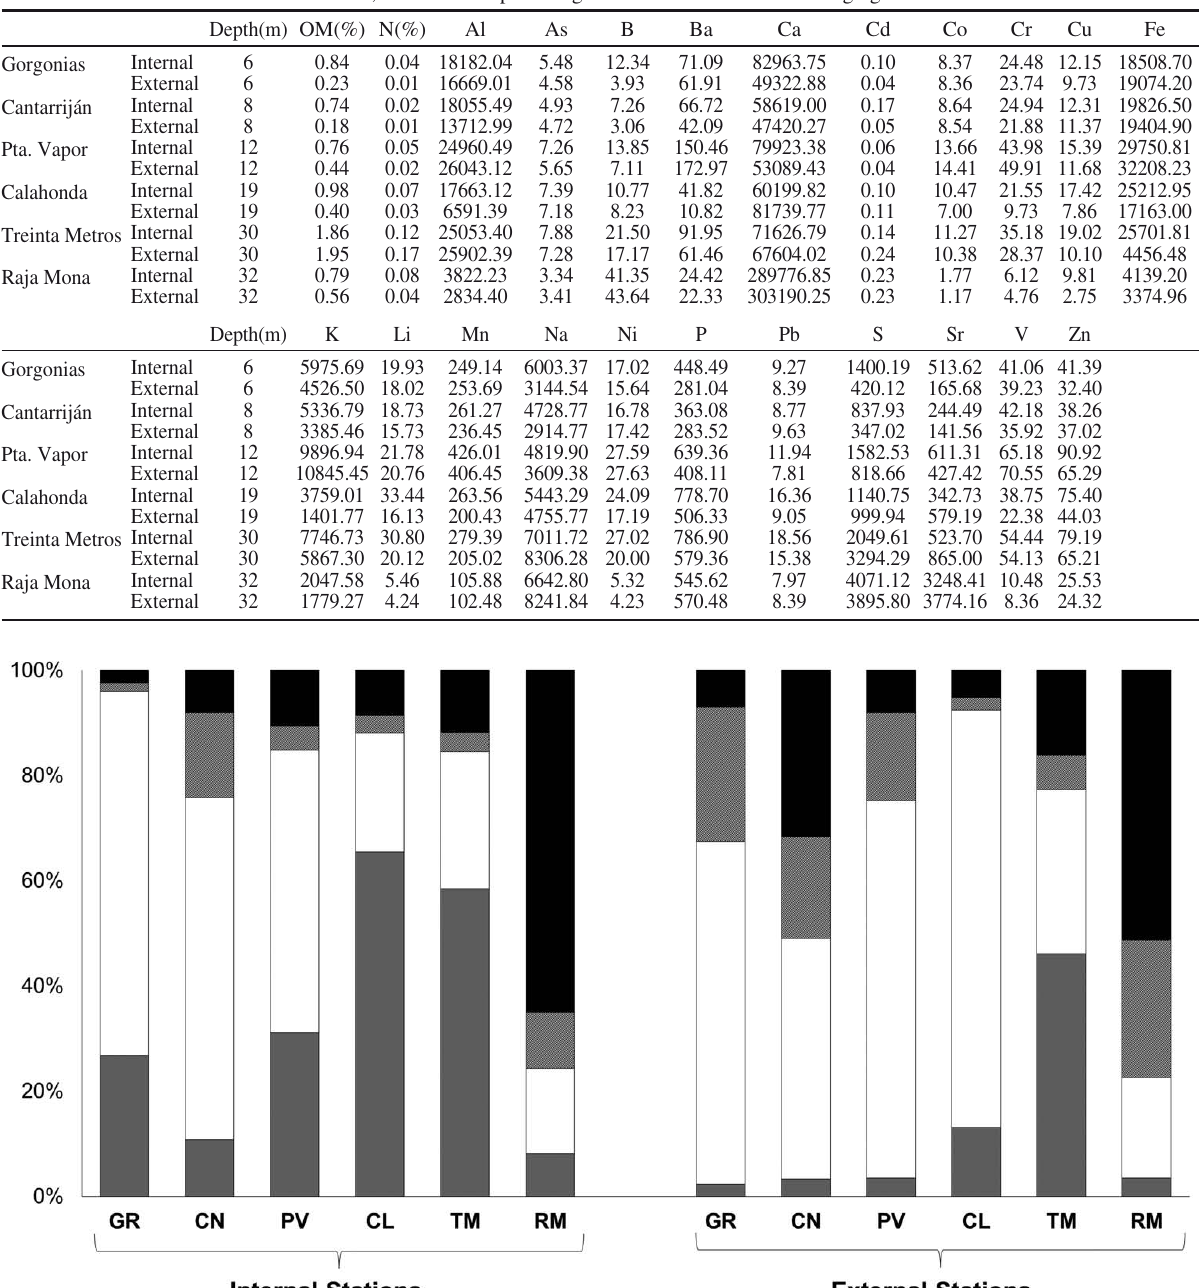
Table 2. – Depth and mean values obtained for sediment variables at each sampling station. OM, organic matter. Depth was measured in meters, OM and N in percentage and the rest of elements in mg/kg.